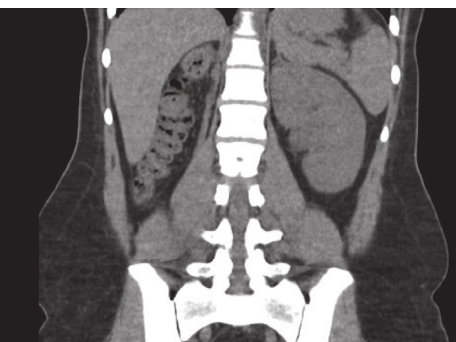
Figure 1: Absent right kidney with compensatory hypertrophy noted in the left kidney.